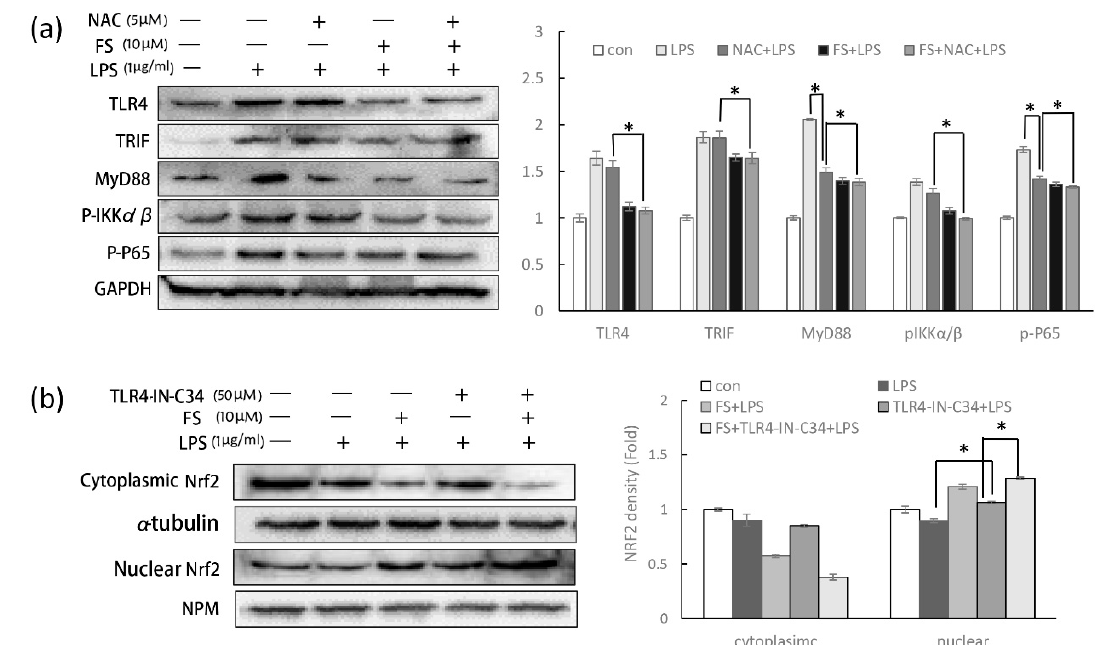
Figure 6. The action of FS under the condition of inflammation or oxidation. ( a ) Scavenging ROS with 5 µM NAC to avoid the effect of oxidation on TLR4/NF- κ B pathway. The proteins expressions were measured with Western blotting. ( b ) TLR4-IN-C34 as the inhibitor of TLR4 was used to discard the influence of TLR4 pathway on Nrf2 translocation. The action of FS on Nrf2 translocation was investigated by Western blotting. * p -value < 0.05.